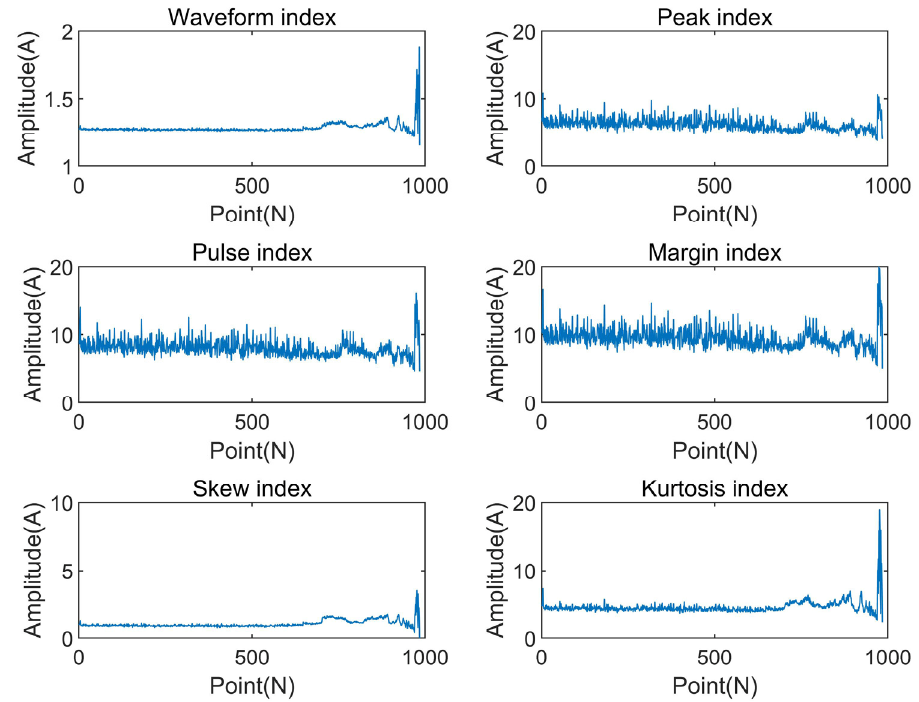
Figure 3. Dimensionless indicators of rolling bearings.